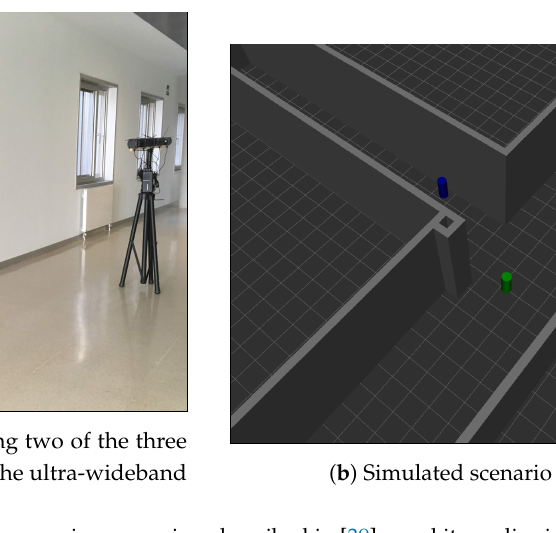
Figure 2. Measurement campaign scenario—described in [39]—and its replica in